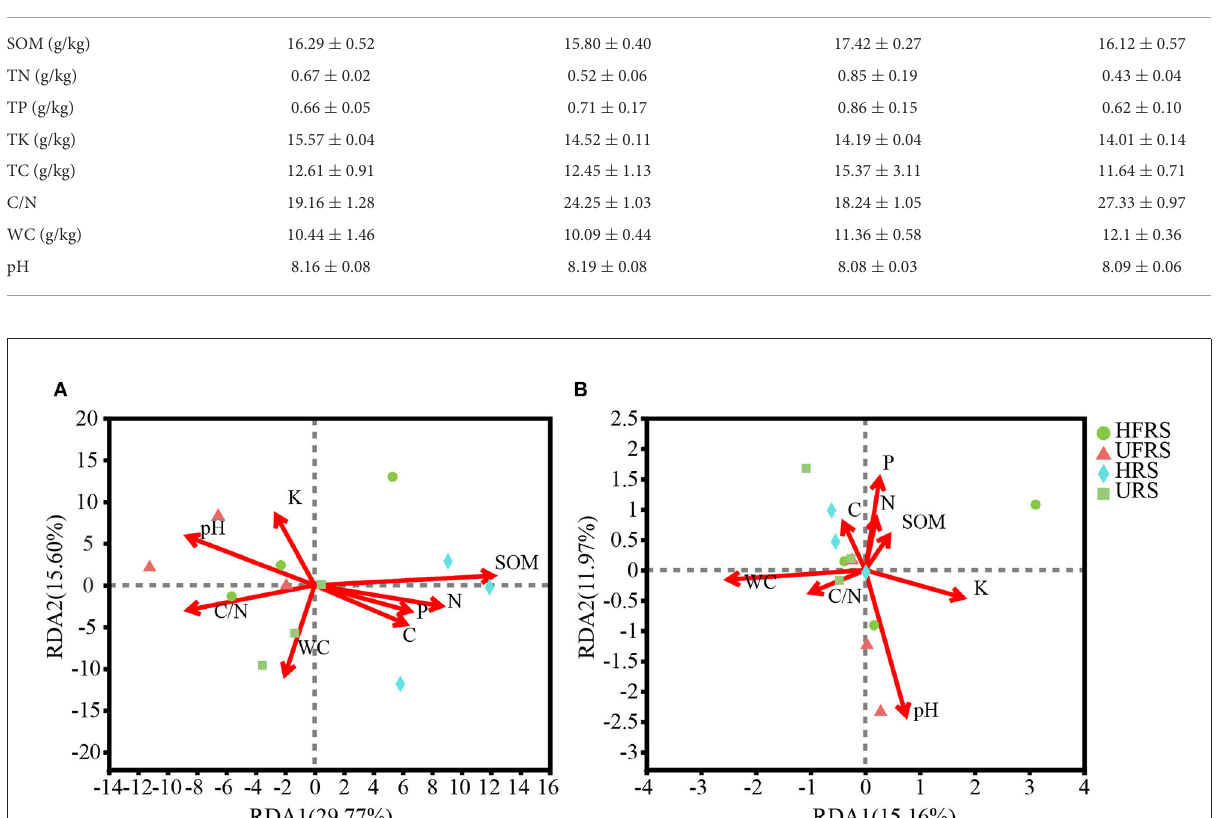
FIGURE7 RDA showing the association between edaphic parameters and the composition of (A) bacterial and (B) fungal communities at the OTU level in the rhizospheric and bulk soils of healthy and unhealthy P. bungeana plants. The length of the arrows correspond to the variance that can be explained by the edaphic variable, while the direction indicates an increase in the magnitude of the edaphic variable. The OTUs were clustered using a sequence similarity threshold of 97%. Abbreviations of variables are given in Figure